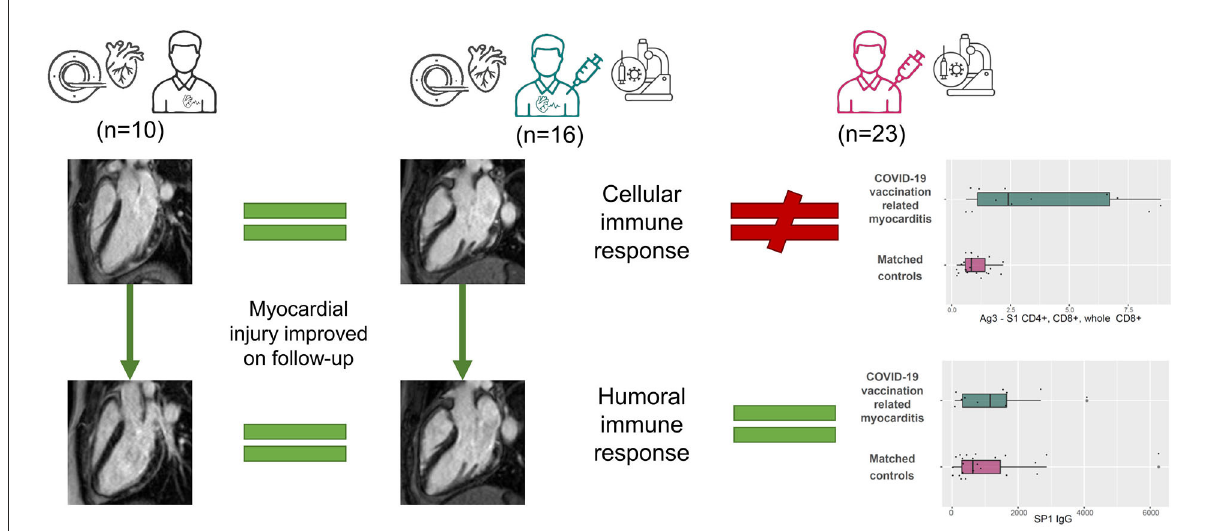
FIGURE1 Visual abstract. We compared the CMR findings of myocarditis patients after COVID-19 vaccination (middle) to those of patients with myocarditis unrelated to COVID-19 immunization or infection (left). We did not find a difference between the groups in the acute (upper images) or follow-up (lower images) scans, but the myocardial injury improved. We compared the immune response of myocarditis patients after COVID-19 vaccination to COVID-19 immunization status-matched controls (right). There was no difference regarding the humoral immune response. In contrast, the cellular immune response was amplified in the myocarditis